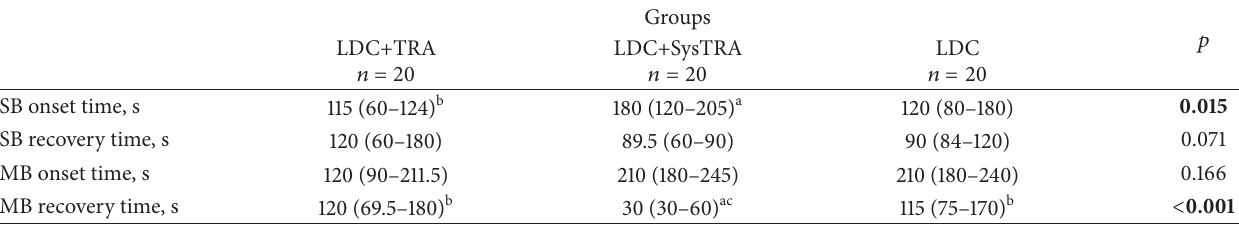
Table 2: Onset and recovery times for sensorial block and motor block.